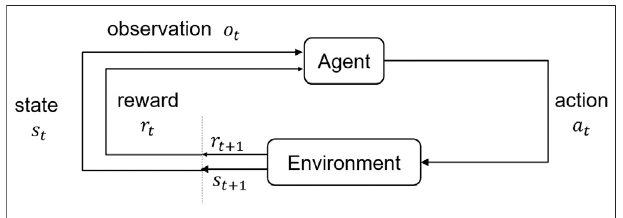
FIGURE 1 | The reinforcement learning feedback loop (adapted from